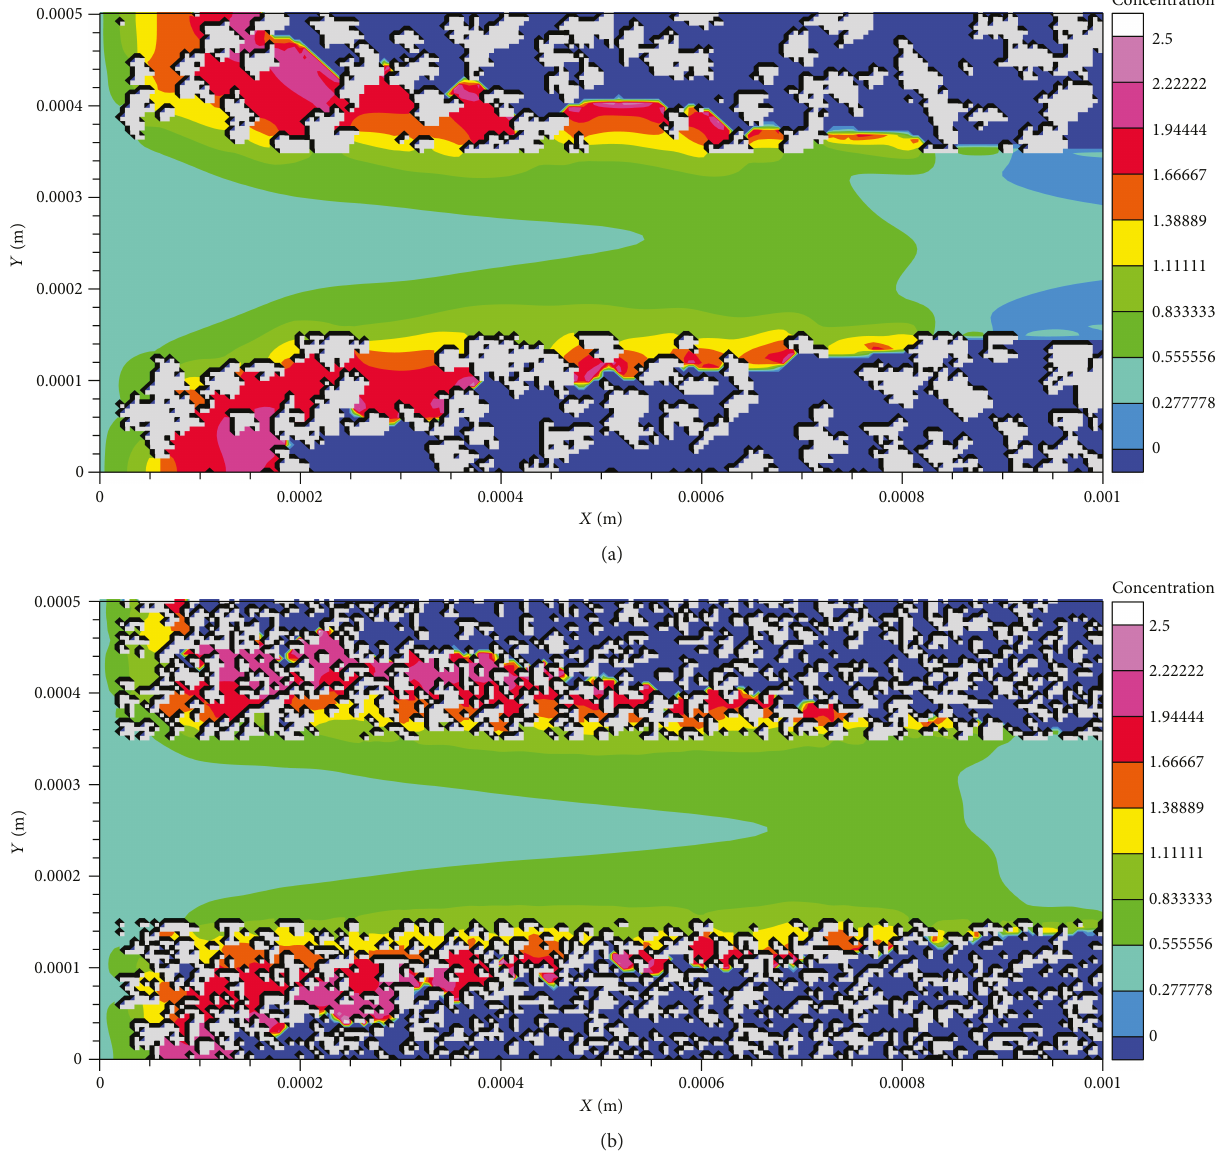
Figure 8: Concentration (mol/L) of species A when Pe =26 and Da=20, for (a) coarser and (b) fi ner nonreactive minerals. In both (a) and (aq) (b), porosity (after dissolution) is near 0.56 but permeability (after dissolution) is 1.56 × 10 − 9 m 2 for (a) and 1.41 × 10 − 9 m 2 for (b). The nonreactive minerals are illustrated in light gray. The areas showing a zero concentration of species A are representing reactive (aq)